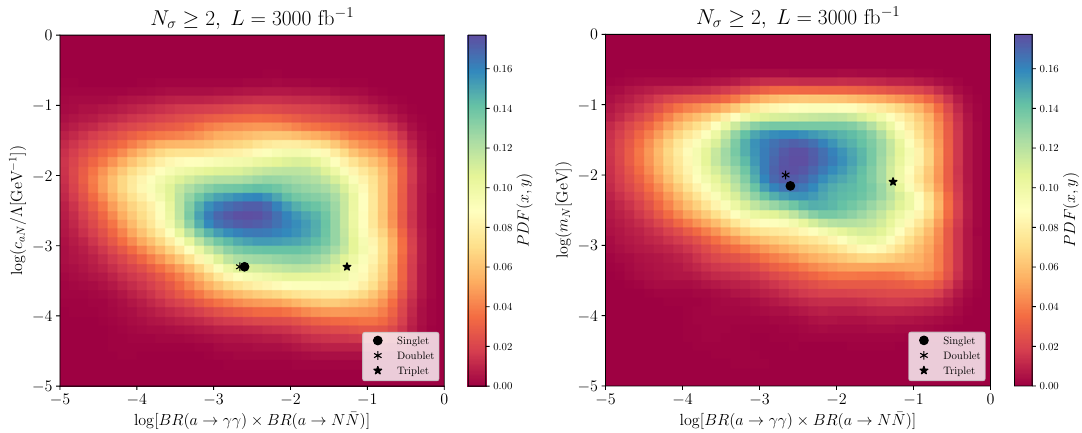
Figure 9 . Heat maps in the plane BR ( a ! (cid:13)(cid:13) ) (cid:2) BR ( a ! N (cid:22) N ) versus c aN and m N are shown at the left and right panels, respectively. In all cases we show the regions that can be probed at 2 (cid:27) and L = 3000 fb (cid:0) 1 . The dot, asterisk and star represent examples of a singlet, doublet and triplet representation of the UV complete model presented in section 5,